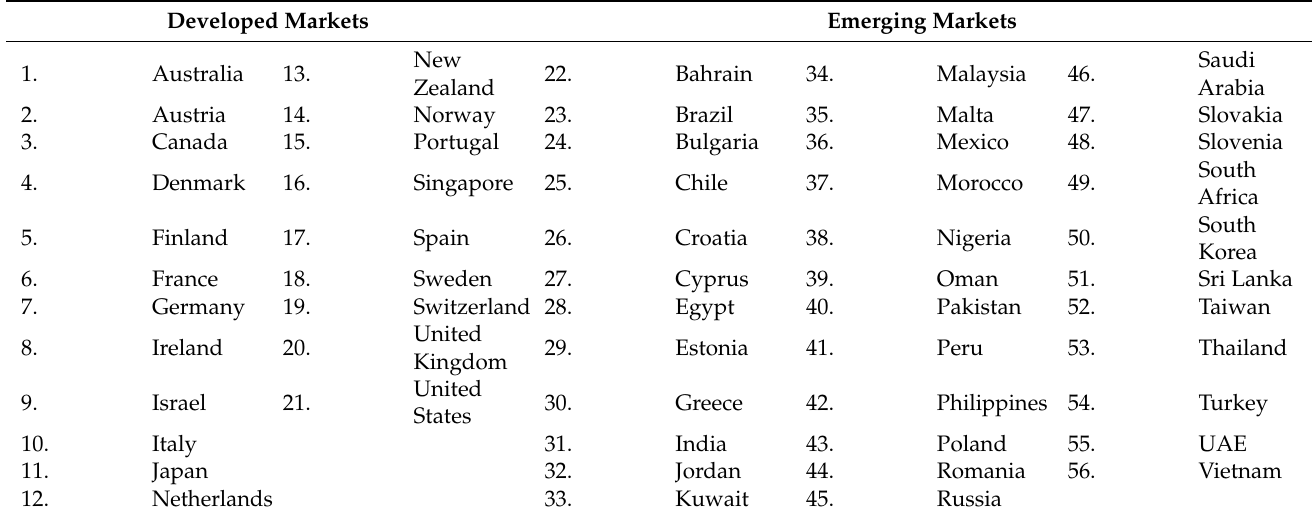
Table 1. Countries covered by the